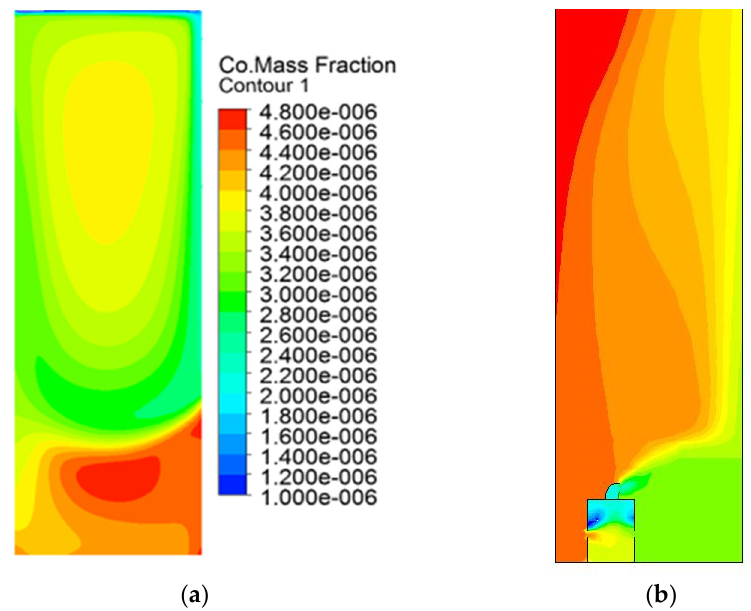
Figure 13. Spatial distribution of a passive tracer in a deep street canyon characterized by an aspect ratio of 3 without ( a ) and with ( b ) the APA scrubber. The figure is a snapshot of the simulation 1300 s from the start (constant tracer). The unit is the tracer molar mixing ratio.